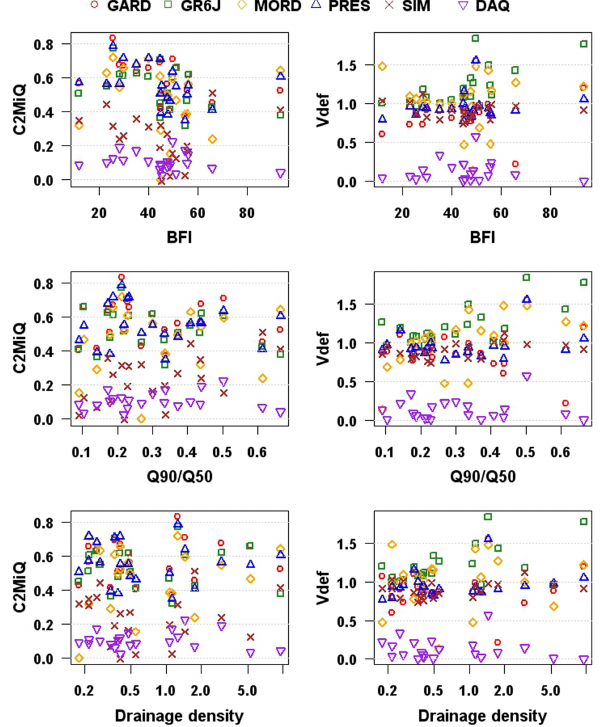
Figure 7. Relation between mean performance in simulation on the two validation periods in terms of C2M i (left panel) and Vdef (right panel), and catchment or streamflow characteristics (top pan- els: base-flow index; middle panels: Q 90 /Q 50 ratio; bottom panels: drainage density) for the 21 catchments and the models